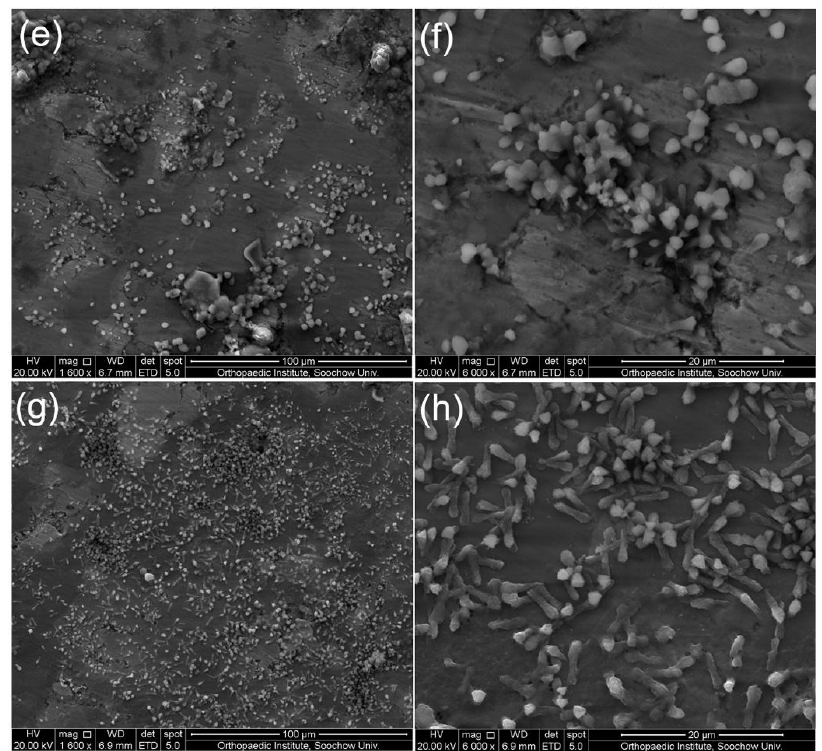
Figure 12. Morphology of osteoblast cells after three days culture on the surface of the sintered composites: ( a , b ) Ti-Ta-Nb-Zr/HA; ( c , d ) 0.5 CNTs; ( e , f ) 0.5 GNFs; ( g , h ) 0.4 CNTs/0.1 GNFs. Nanomaterials 2018 , 8 , x FOR PEER REVIEW